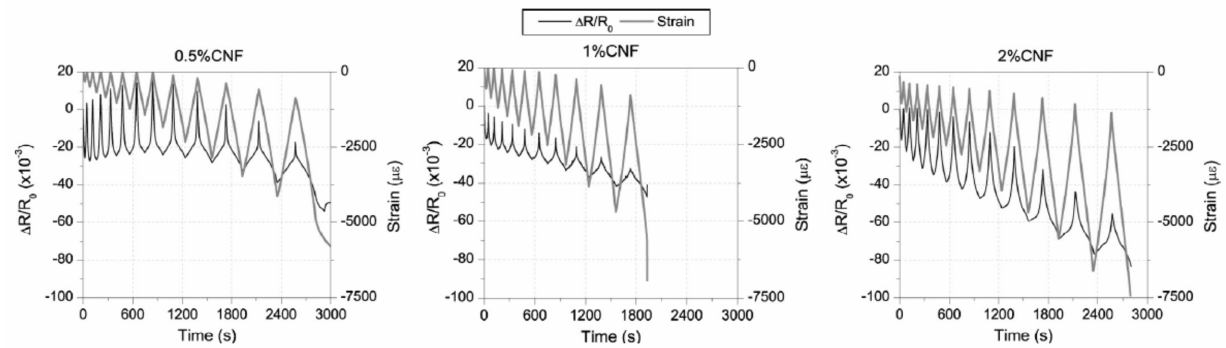
Figure 28. Relationship between resistance and strain with time for three types of cement pastes with 0.5%, 1% and 2% CNF concentration. Reproduced with permission from [10], Elsevier,